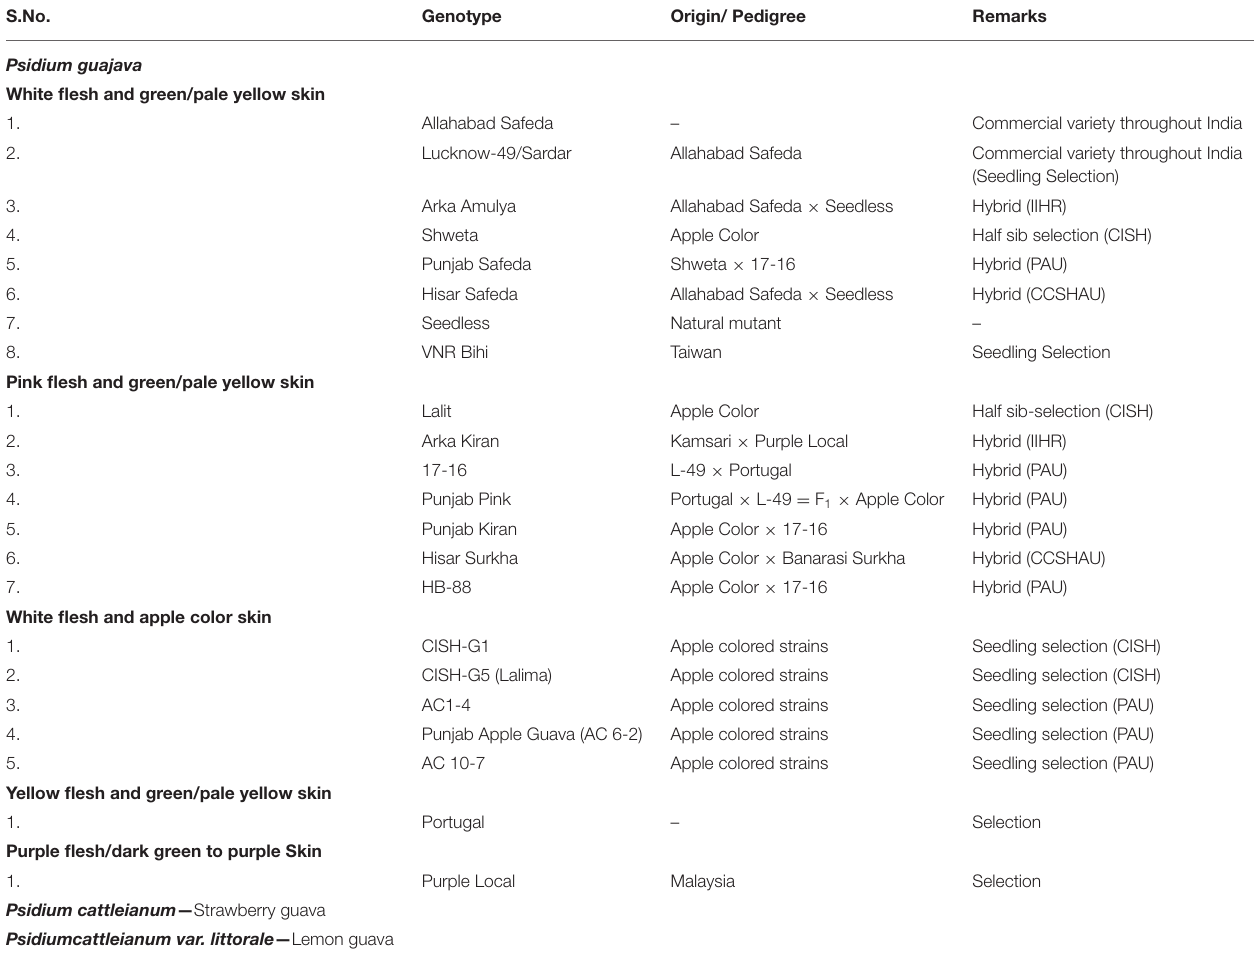
TABLE 1 | Popular guava genotypes/cultivars widely cultivated or used in breeding programs in India. S.No.